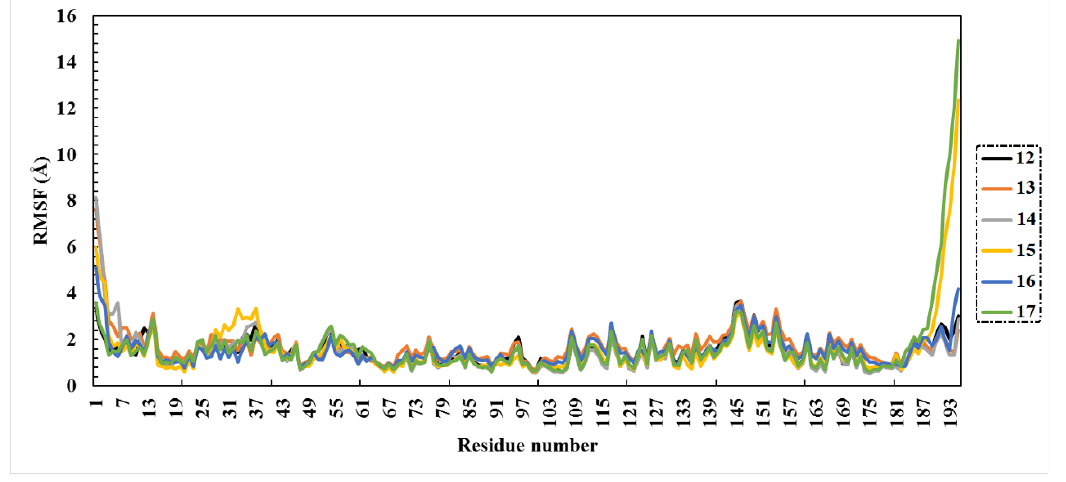
Figure 4. Root-mean-square fluctuation (RMSF) of the six selected complexes (Omicron- 12 , Omicron- 13 , Omicron- 14 , Omicron- 15 , Omicron- 16 , Omicron- 17 ).